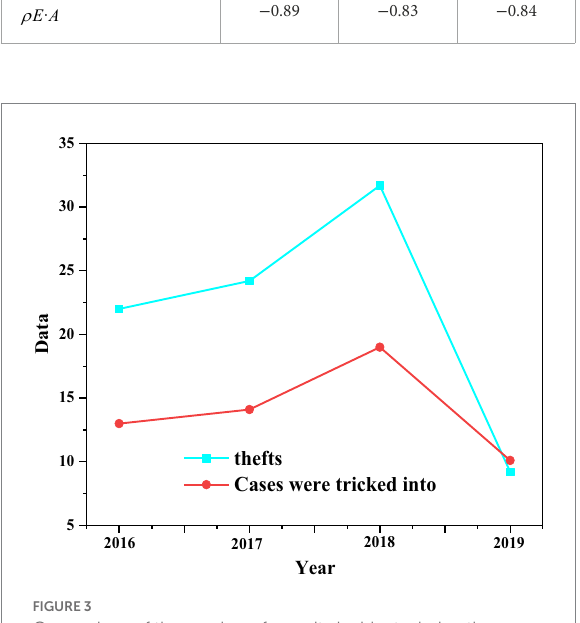
FIGURE 3 Comparison of the number of security incidents during the freshman year of 2016 to